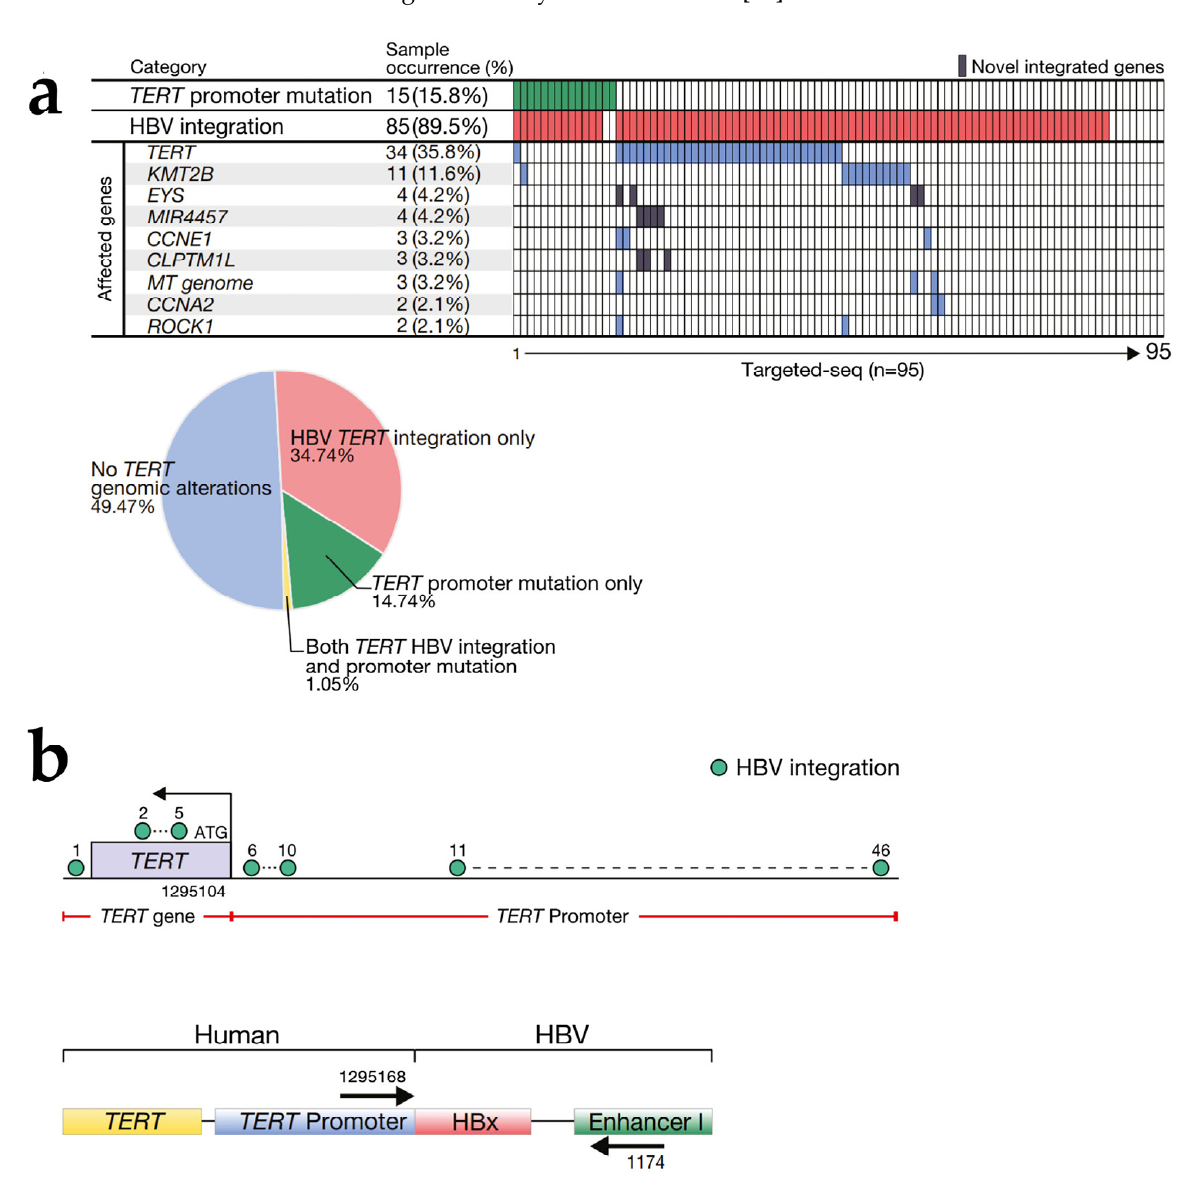
Figure 2. HBV DNA integration plays a very important role in HBV-induced HCC pathogenesis and can lead to insertional mutations in cancer-related genes. Among them, the most common site of HBV-mediated insertional mutation is located in the TERT promoter. ( a ) Common HBV DNA integration sites in HCC patients. The pie chart shows the distribution of TERT genomic alterations detected in the HCC cohort; ( b ) Schematic illustration showing frequent TERT HBV integration and its genomic location in human HCC tissues. After HBV integration in human HCC, the direct linkage of HBV EnhI and HBx DNA sequences to the human TERT promoter leads to TERT activation and telomerase overexpression, promoting cancer development. Reprinted with permission from Ref. [42]. 2020, John Wiley and Sons.